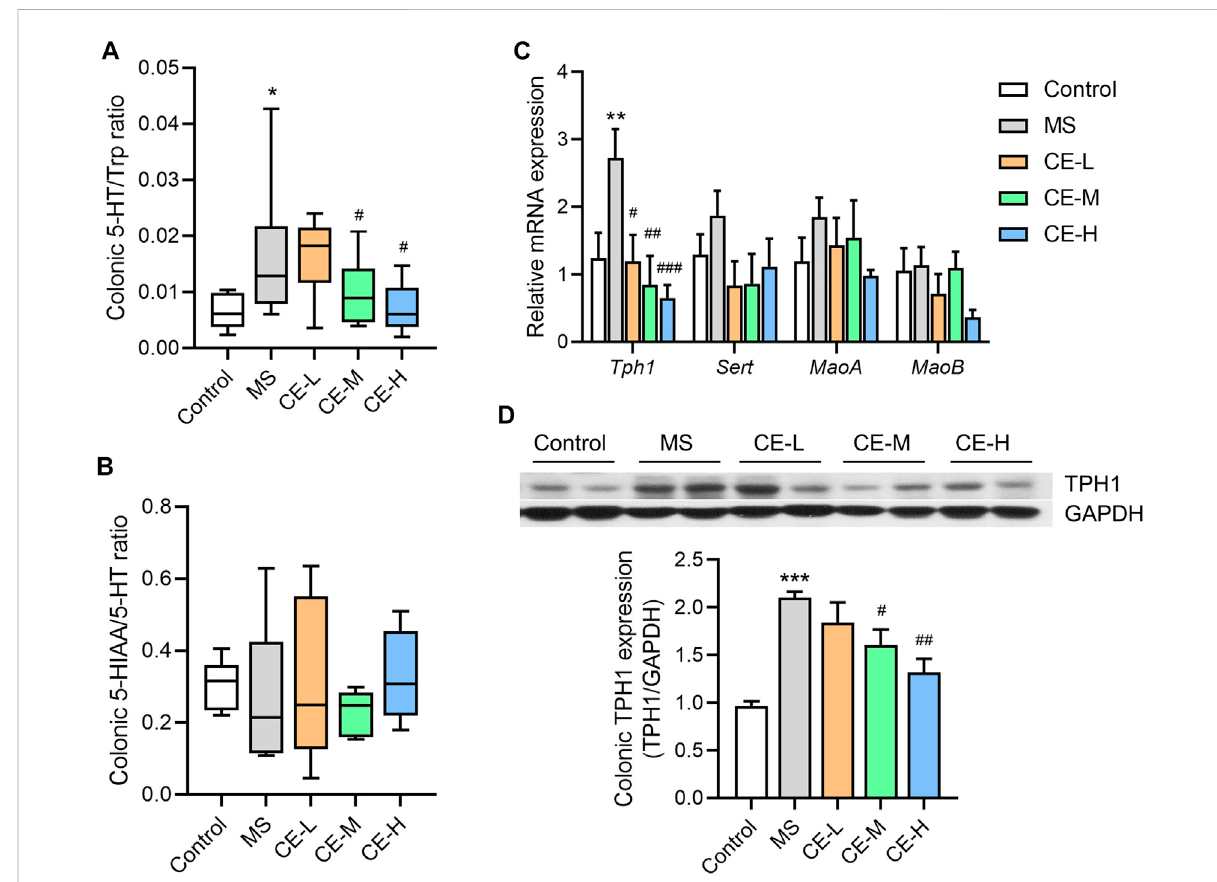
FIGURE 3 CE inhibits colonic 5-HT synthesis and TPH1 protein expression in MS rats (A,B) The ratios of 5-HT to Trp and 5-HIAA to 5-HT (n = 5 – 6/group); (C) Relative expression of colonic genes related to 5-HT synthesis and catabolism (n = 6/group); (D) Expression of colonic TPH1 protein among different rat groups (n = 3/group). One way ANOVA analysis is used for statistics and signi fi cance is expressed as *, p < .05; **, p < .01; ***, p < .005 compared with the control group; #, p < .05; ##, p < .01; ###, p < .005 compared with the MS model